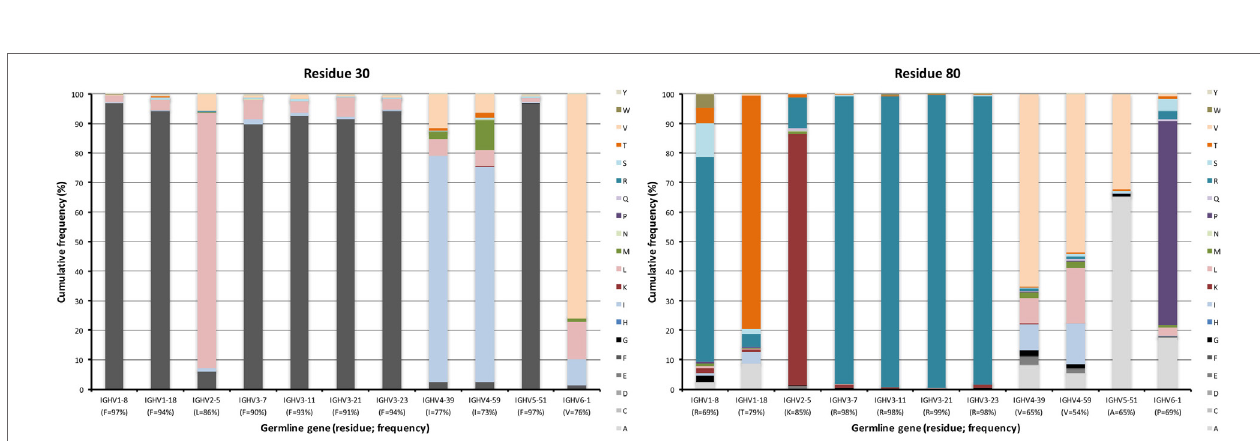
FigUre 9 | Substitutions of upper core residues 30 and 80 as introduced during somatic hypermutation processes of IgG-encoding genes derived from different germline genes. Substitution of residue 28 is shown in Figure 4 .